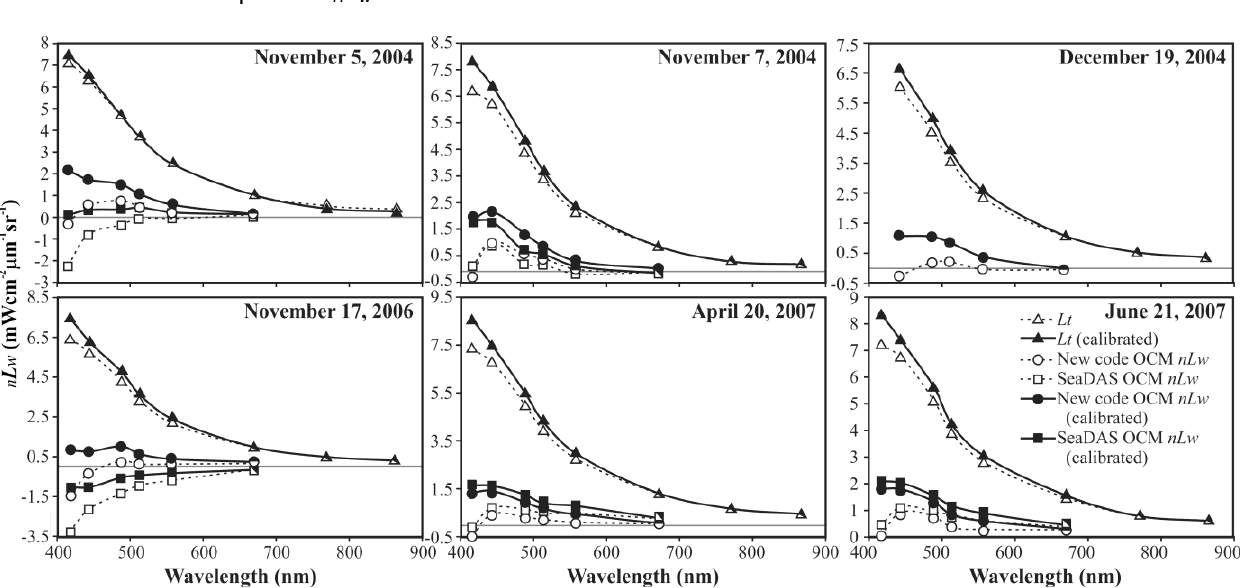
Figure 7. Comparison of OCM TOA radiances before and after vicarious calibration, and the corresponding L values computed by the new code and SeaDAS. Solid dots with n w solid lines represent vicariously calibrated L and TOA radiances, and hollow dots with n w dotted lines represent L and TOA radiances before vicarious calibration. n w